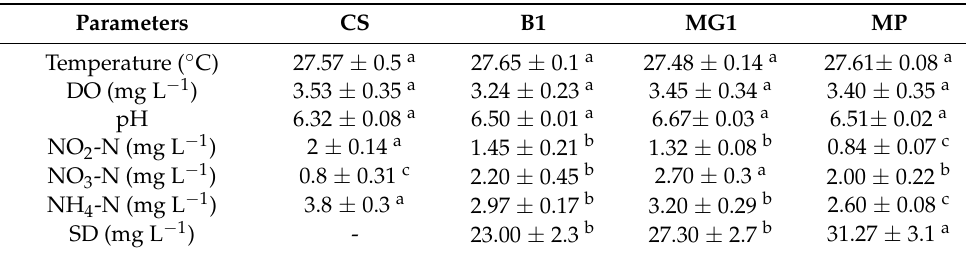
Table 5. Mean ± SEM of water quality parameters during the culture of red hybrid tilapia fingerling in biofloc system with probiotics.